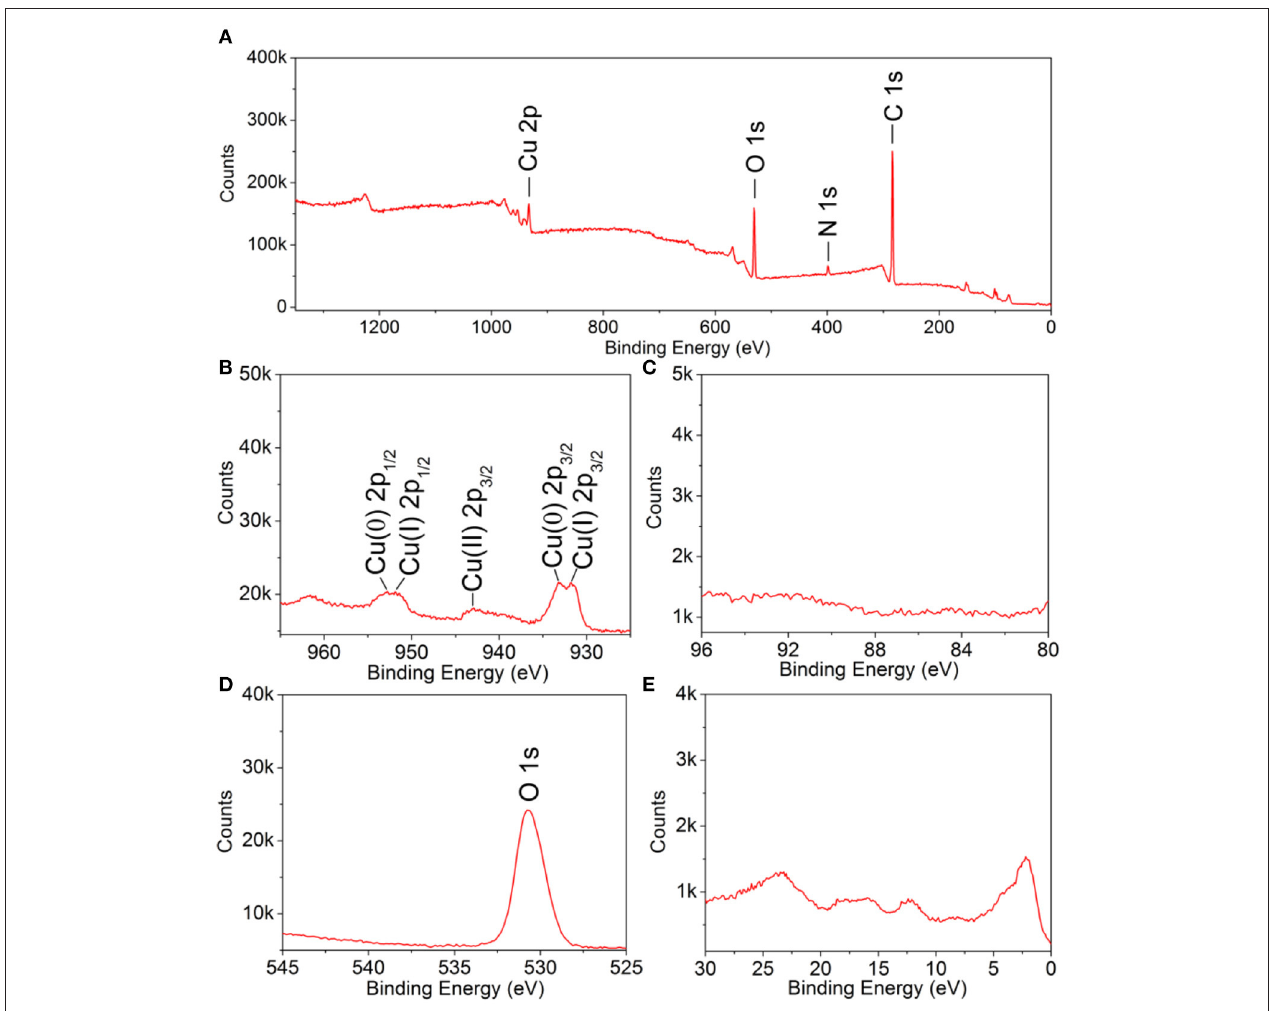
FIGURE 4 | X-ray photoelectron spectroscopy spectra of 119-nm Au@Cu x O core–shell MPNSs: (A) a survey scan, (B) Cu 2p; (C) Au 4f, (D) O 1s, and (E)